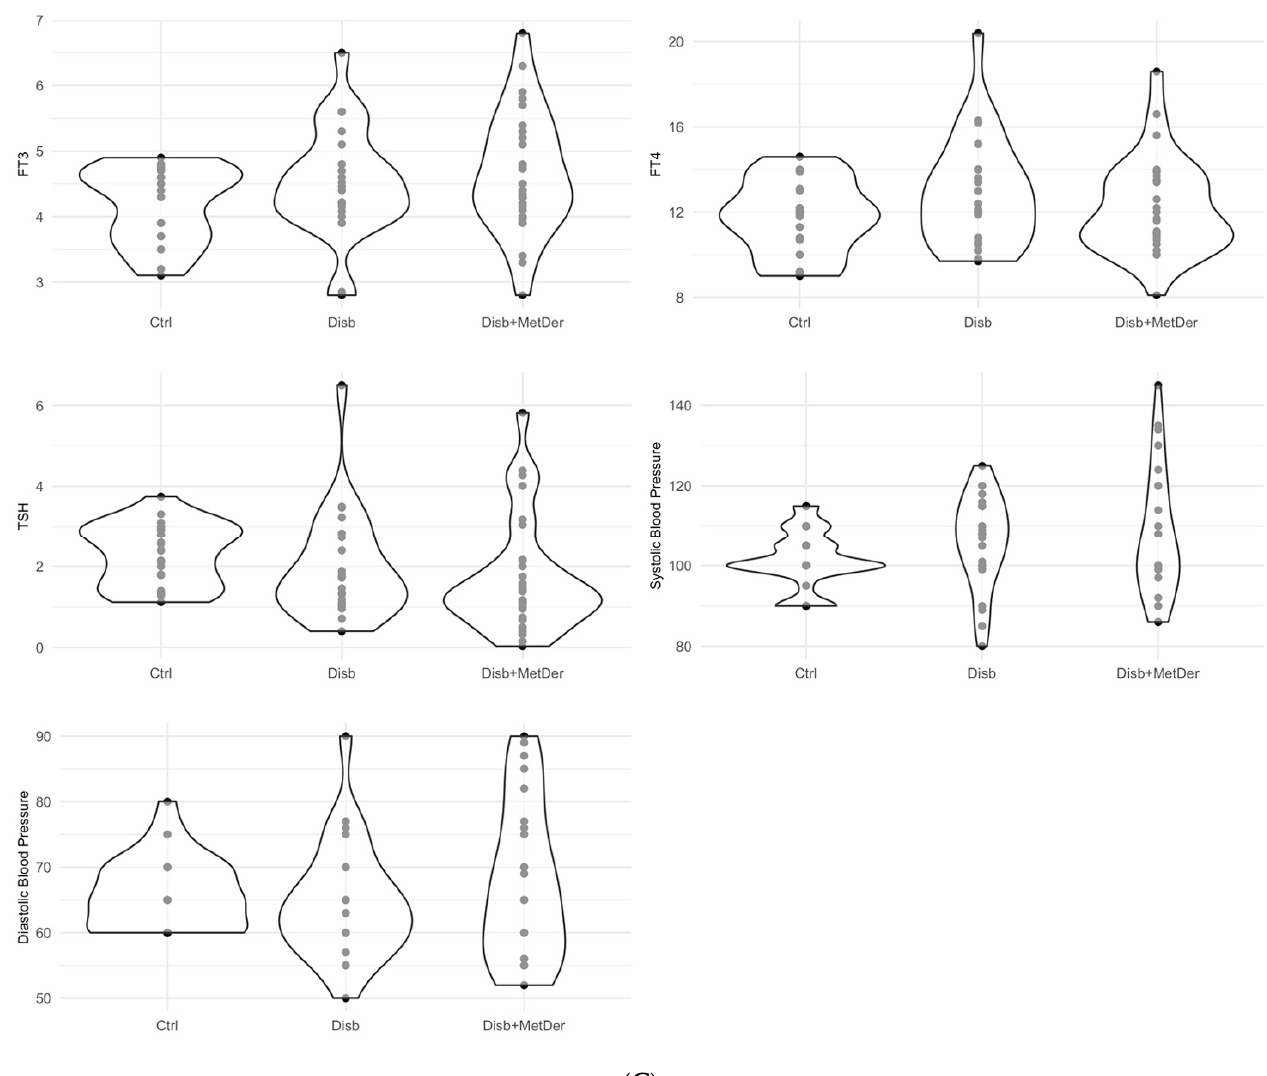
Figure A1. Violin plots showing the distribution of the numeric variables separated for the classes of the group studied. The graphs were distributed in three different panels ( A – C ) due to space constraints: Control children (Ctrl), Children with neuromotor impairment (Disb), Children with neuromotor impairment and Metabolic derangement (Disb + MetDer).